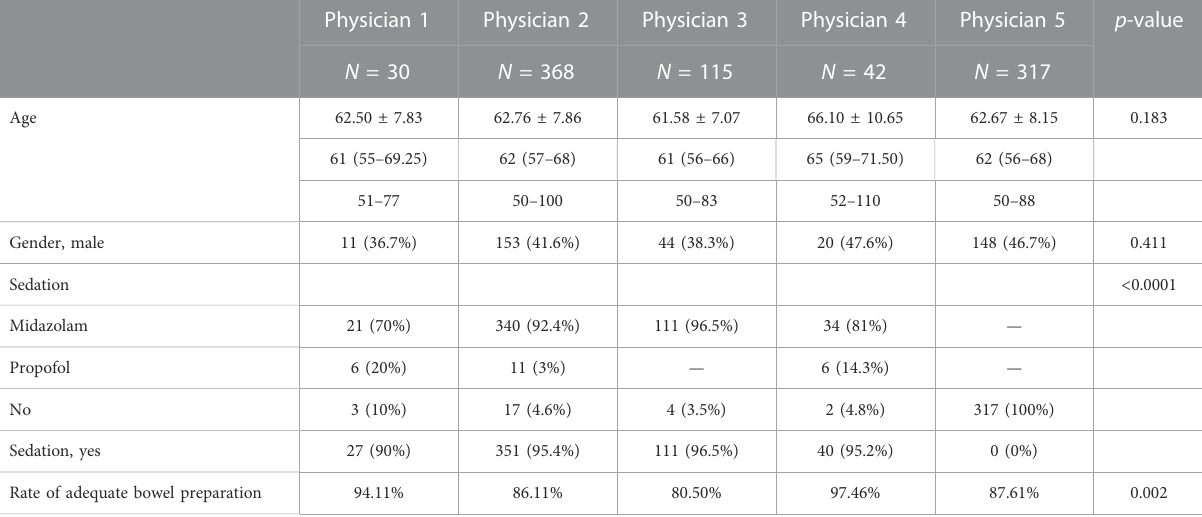
TABLE 4 Characteristics of the patients in ESGE